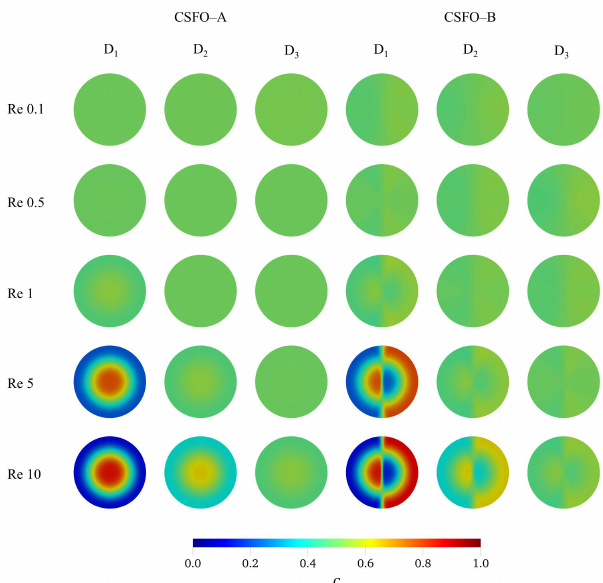
Figure 4. The distribution of scalar concentrations on the exit cross-section of the CSFO–A (first three columns on the left) and CSFO–B (last three columns on the right) micromixer